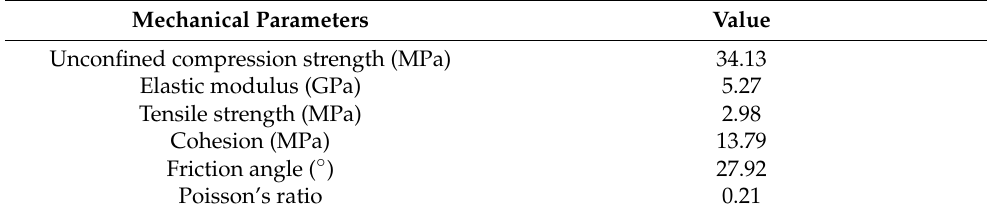
Table 1. Mechanical parameters of cement